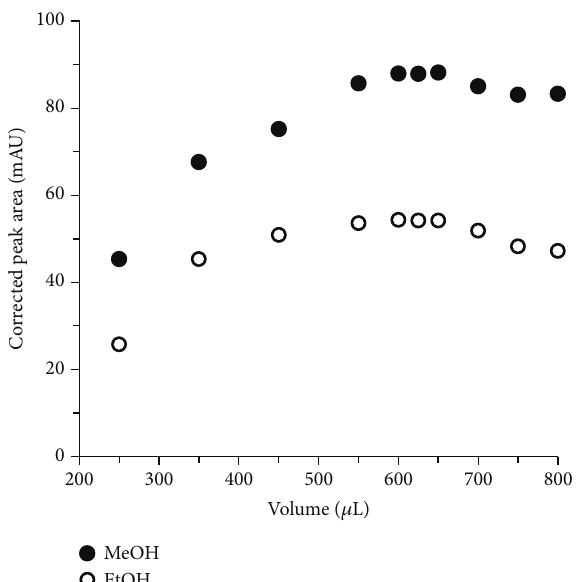
Figure 5: The influence of volume and type of solvent on extraction yield (expressed as corrected peak area).